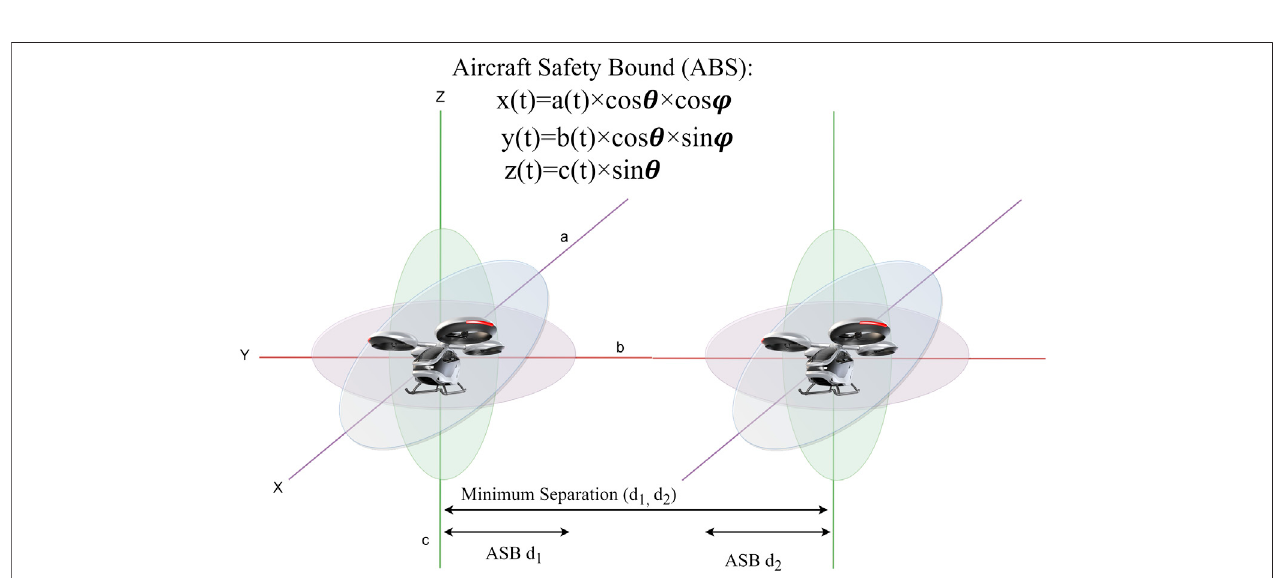
FIGURE 7 | Seven components of advanced UTM system.